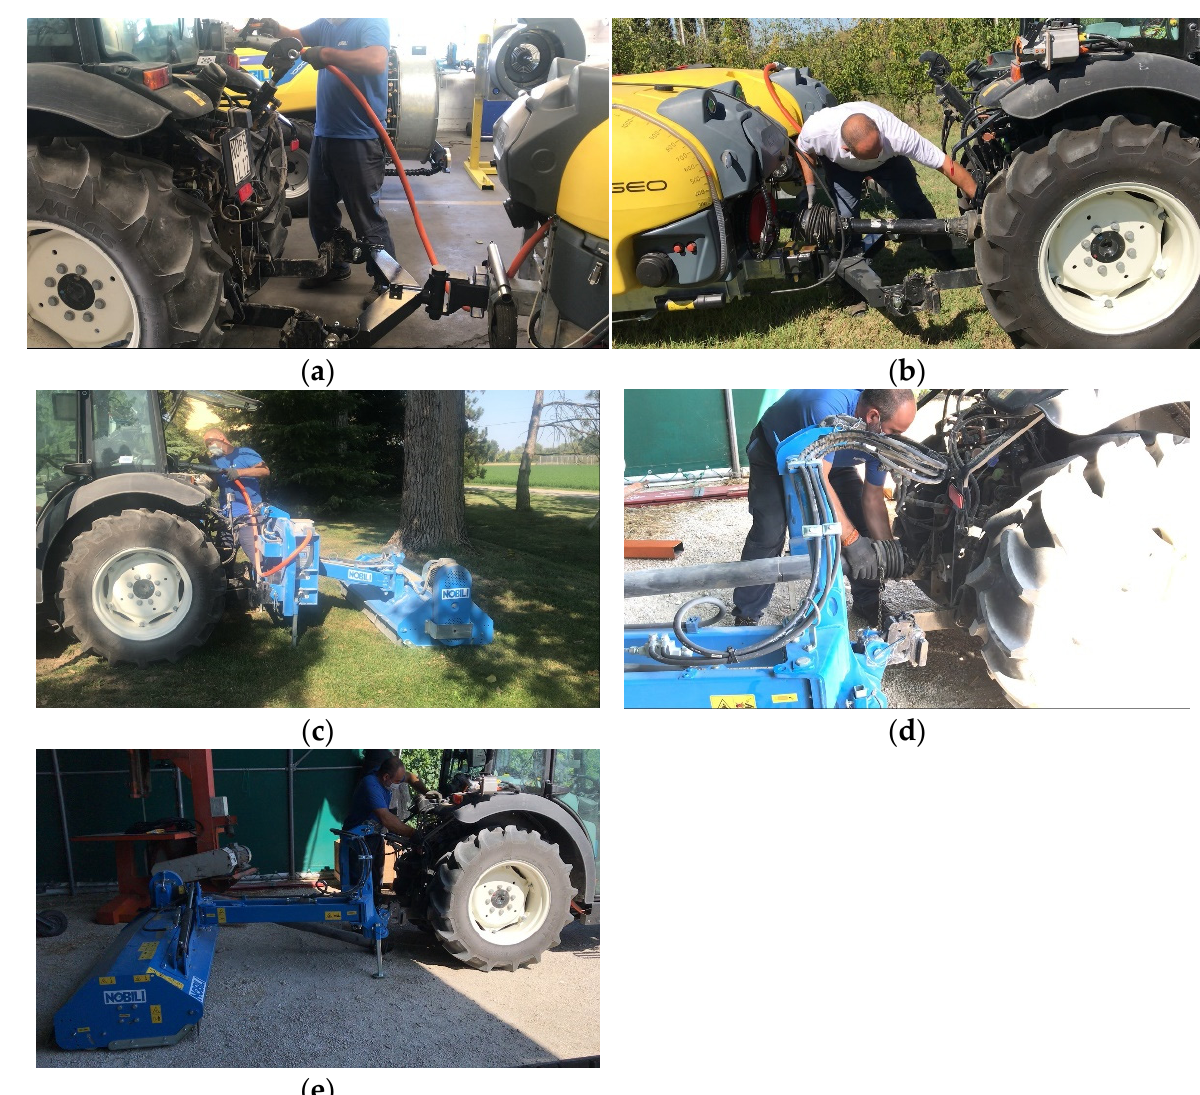
Figure 11. Video frames of the linkage process of the eSprayer ( a ) and eMulcher ( c ) during the plugin of the AEF HVPI; linkage process of the mSprayer ( b ) and mMulcher during the mounting of the cardan shaft ( d ) and the hydraulic remotes ( e ).